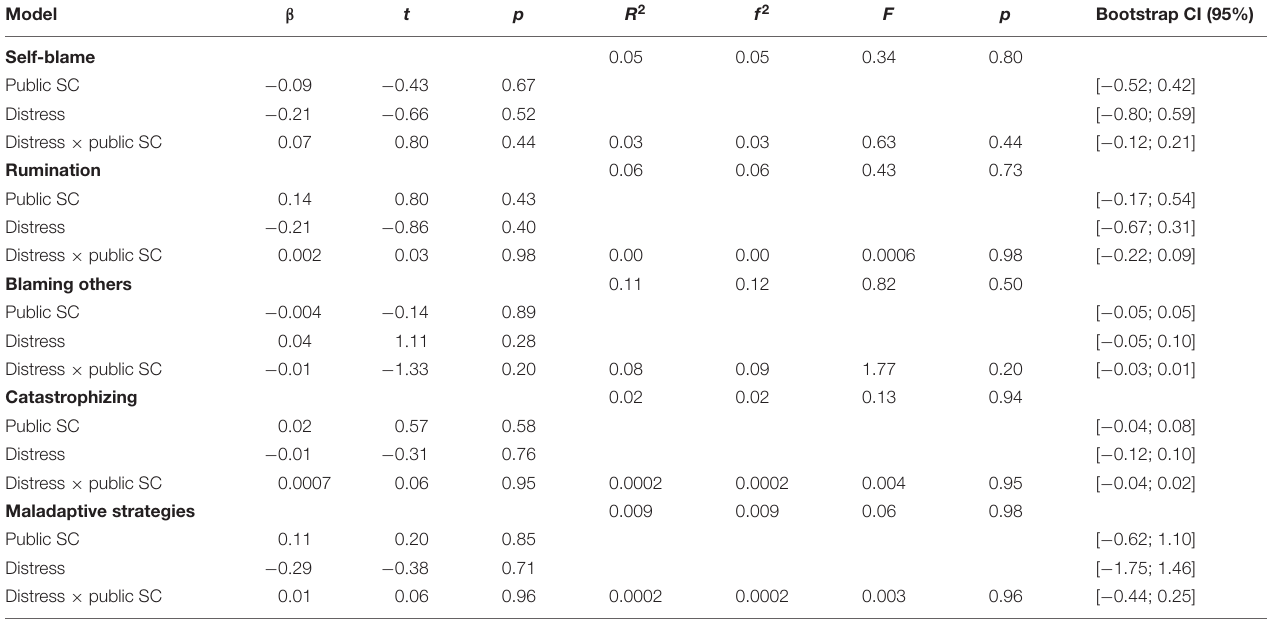
TABLE 9 | Multiple regression analyses predicting maladaptive emotion regulation strategies as a function of public SC, distress and their interaction in the control group.